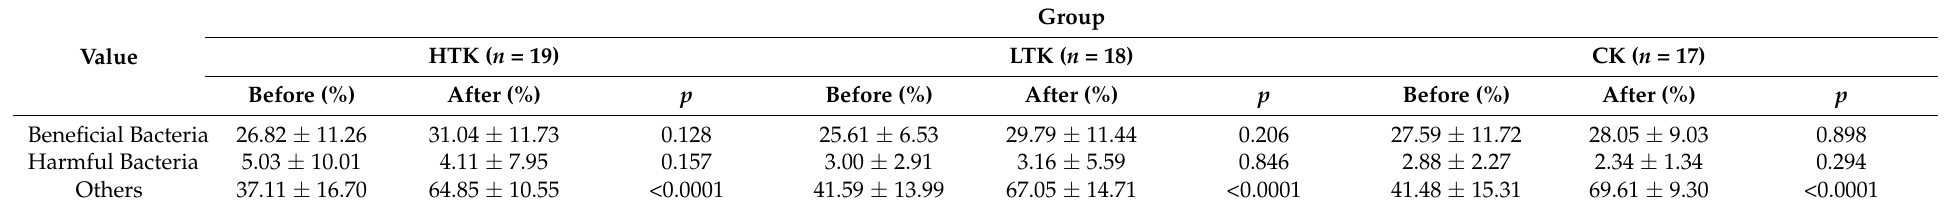
Table 4. Comparison of microbiome changes in stools between three